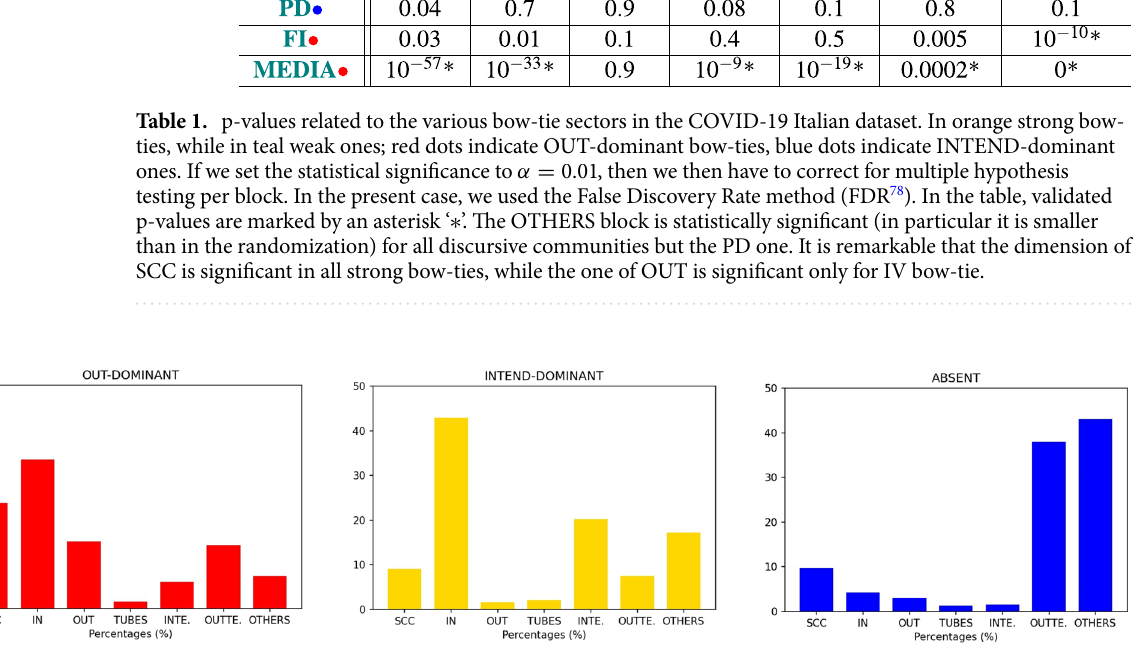
Figure 4. Distribution of the percentage of verified users in each sector of the discursive communities with, respectively, OUT-dominant, INTEND-dominant and not informative bow-ties. Each bar-chart displays the average percentage of verified users in a specific sector, calculated respectively for all the OUT-dominant, INTEND-dominant and not informative bow-ties. In the cases of OUT-dominant and INTEND-dominant bow-ties, the highest percentages of verified accounts can be found in the IN group. Moreover, in OUT- dominant bow-ties, we can found a relevant percentage of verified accounts also in the SCC. Naturally, for those communities with no bow-tie structure the verified accounts are mostly placed in the OTHERS sector and, to less extent, in the OUTTENDRILS